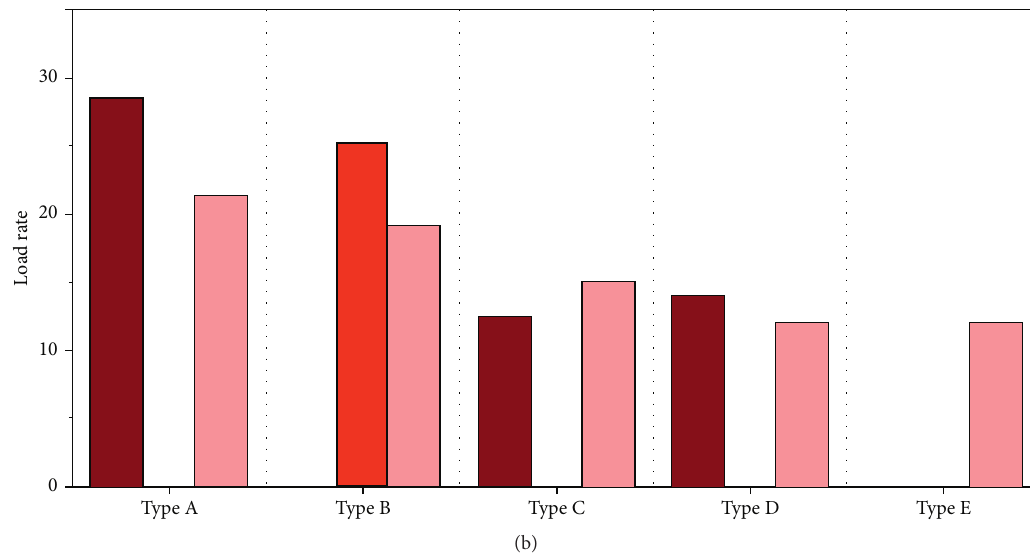
Figure 9: Comparison of load rate before and after optimization. (a) Load rate before optimization. (b) Load rate after optimization.